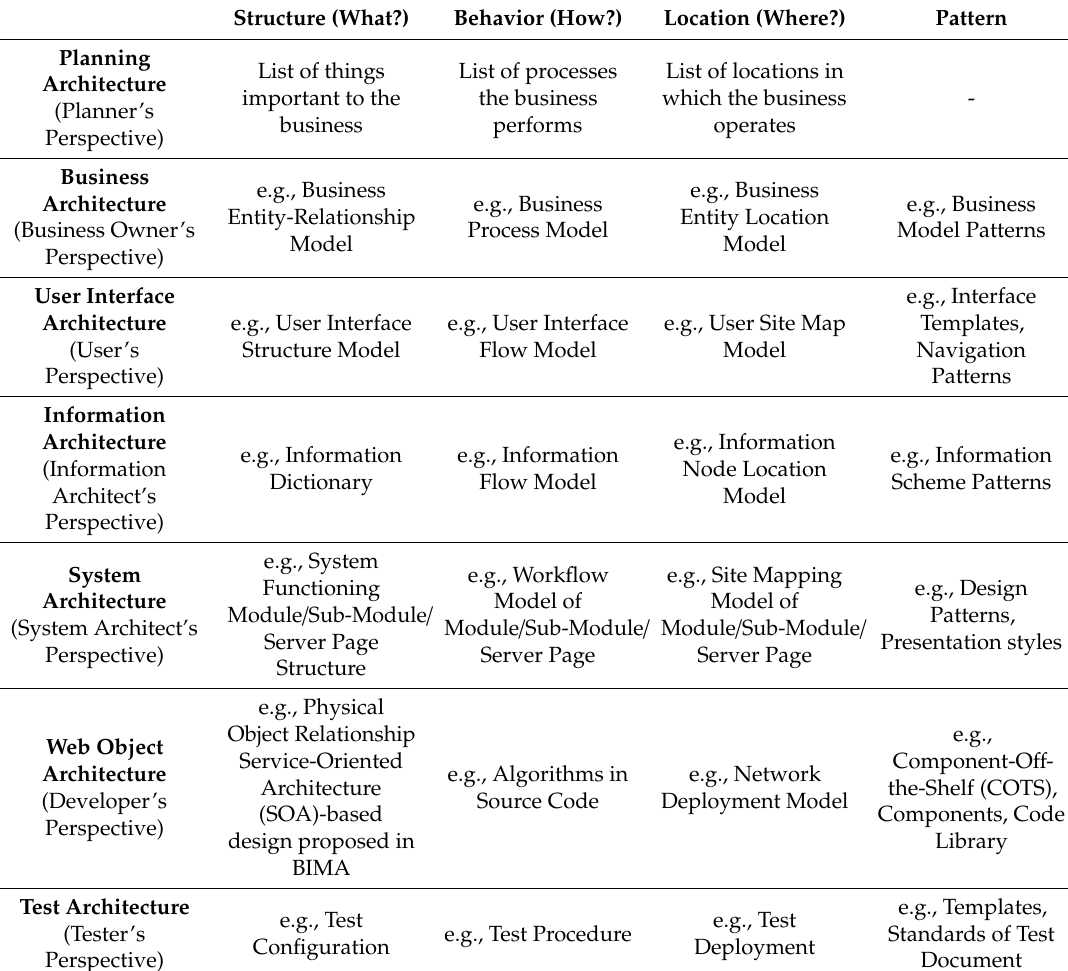
Table 1. Web Application Architecture Framework (WAAF) Matrix. BIMA: Business Integrity Modeling and